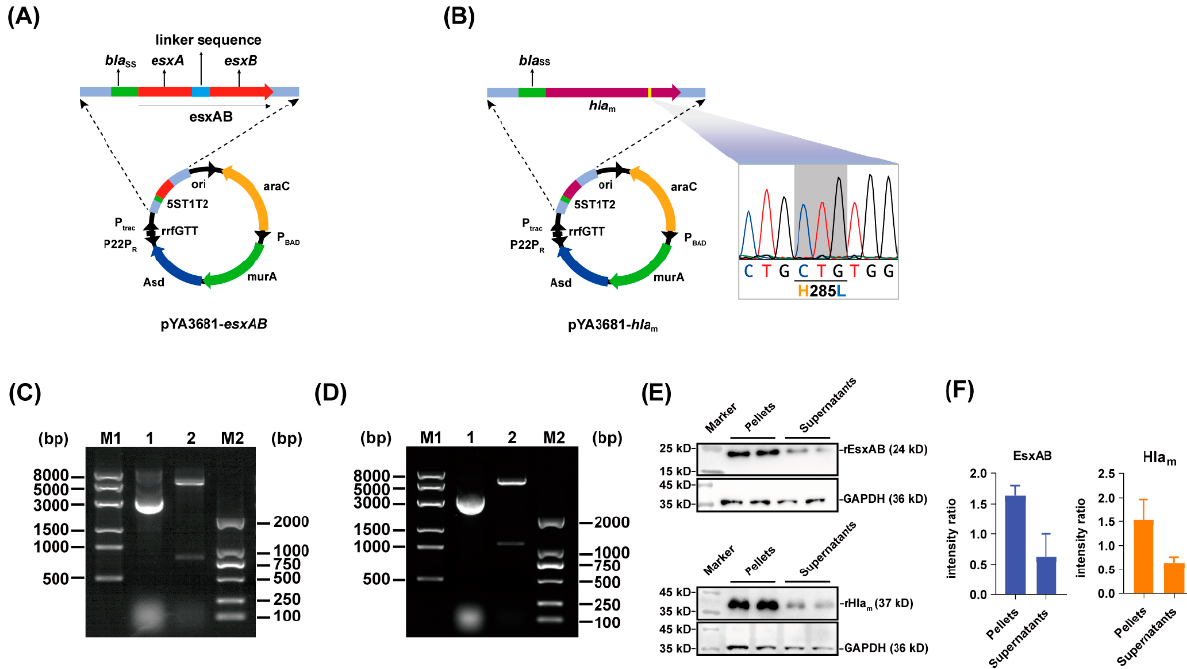
Figure 1. Construction of pYA3681 − esxAB and pYA3681 − hla m plasmids and protein expression in recombinant strains of χ 11802. ( A ) Construction scheme of pYA3681 − esxAB . ( B ) Construction scheme of pYA3681 − hla m . ( C ) The recombinant pYA3681 − esxAB plasmid was identified by re- striction endonuclease digestion. 8K DNA marker (Lane M1), pYA3681 − esxAB plasmid (Lane 1), pYA3681 − esxAB plasmid double-enzyme digested with Nco I and Sma I (Lane 2), and 2K DNA marker (Lane M2). ( D ) The recombinant pYA3681 − hla m plasmid was identified by restriction endo- nucleases. 8K DNA marker (Lane M1), pYA3681 − hla m plasmid (Lane 1), pYA3681 − hla m plasmid dou- ble-enzyme digested with Nco I and Sma I (Lane 2), and 2K DNA marker (Lane M2). ( E ) rEsxAB and rHla m synthesis in recombinant strains of χ 11802 and the recombinant proteins released in the su- pernatant culture medium were analyzed by Western blot. ( F ) Intensity ratio of EsxAB and Hla m expression in recombinant strains of χ 11802.